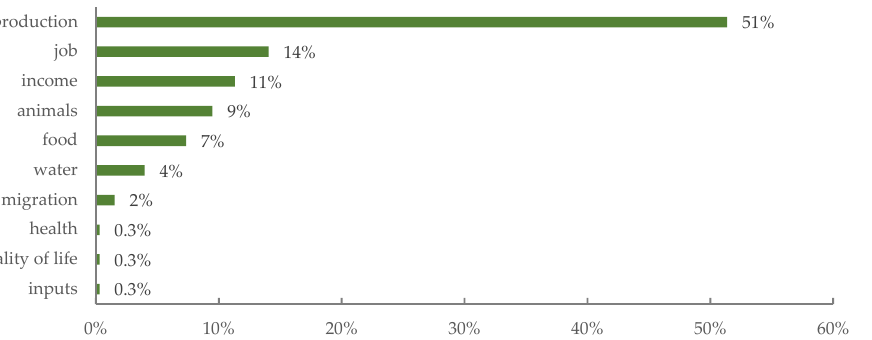
Figure 9. Perception of the main social impacts related to drought (Source: prepared by the authors).